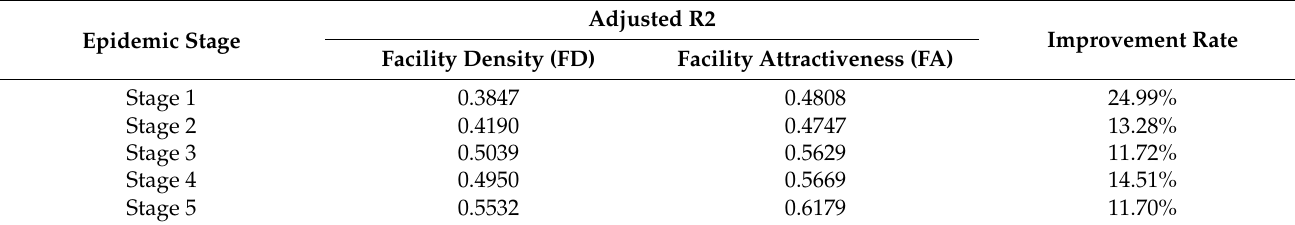
Table 5. Phased modeling results of the adjusted R 2 with FDs and